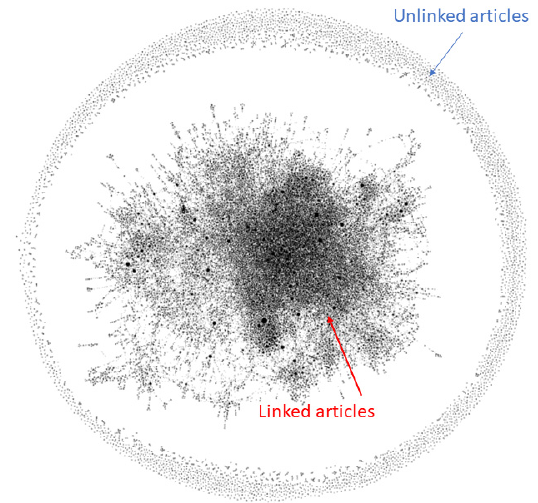
Figure 7. Manuscripts published in MDPI’s Energies journal.